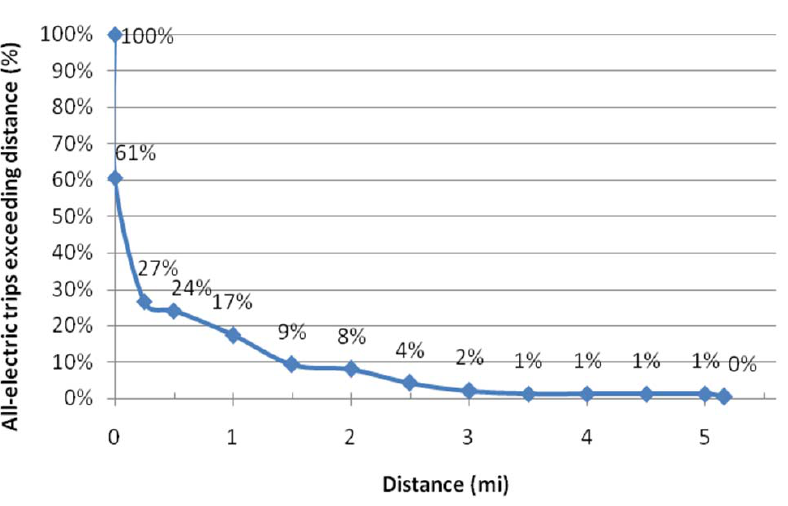
Figure 4. All-electric trips exceeding a given trip distance (%).